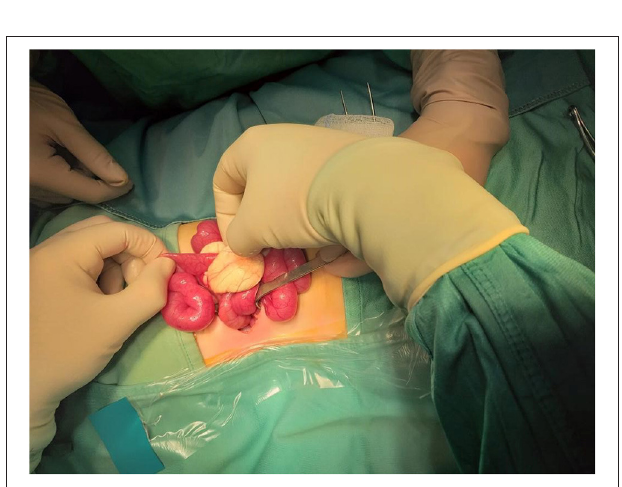
FIGURE 3 | Laparotomy confirmed the presence of mesenteric cyst in the first jejunal loop, 7cm in